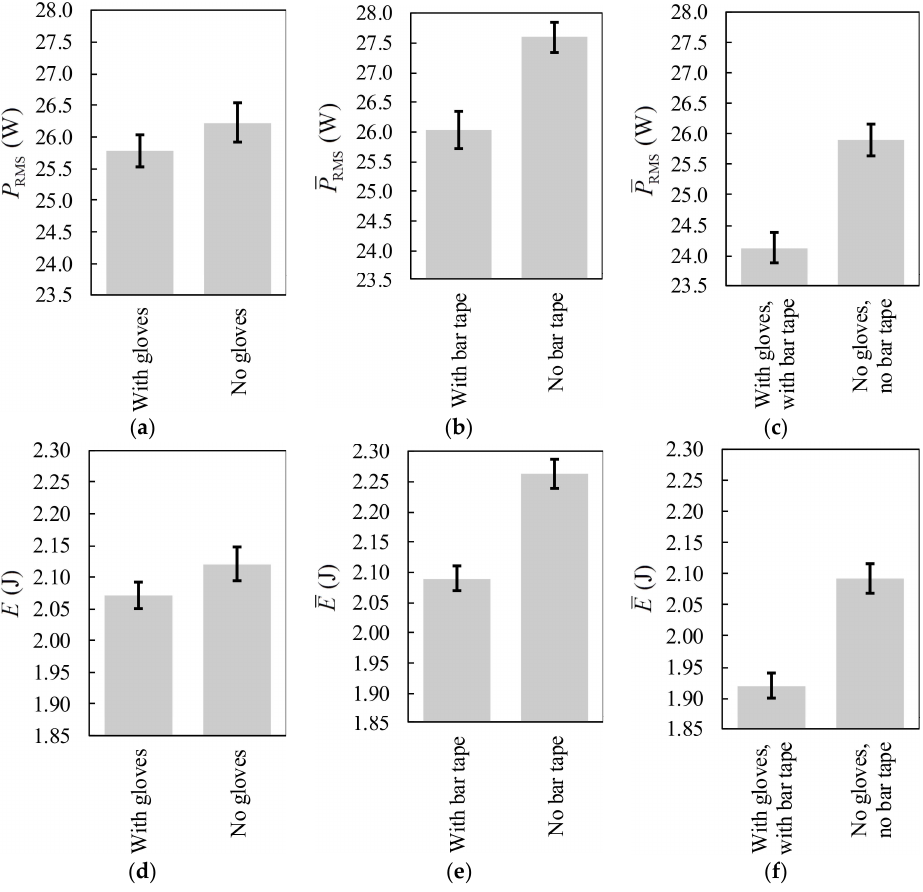
Figure 3. Results in terms of power and energy for the three pairs of conditions: ( a , d ) With gloves vs. no gloves; No bar tape; ( b , e ) With bar tape vs. no bar tape; No gloves; ( c , f ) With gloves and bar tape vs. no gloves and no bar tape. Uncertainty bars are at a confidence level of 95%. Table 1. Change in power and energy, and p -values for the three pairs of conditions. Pairs of